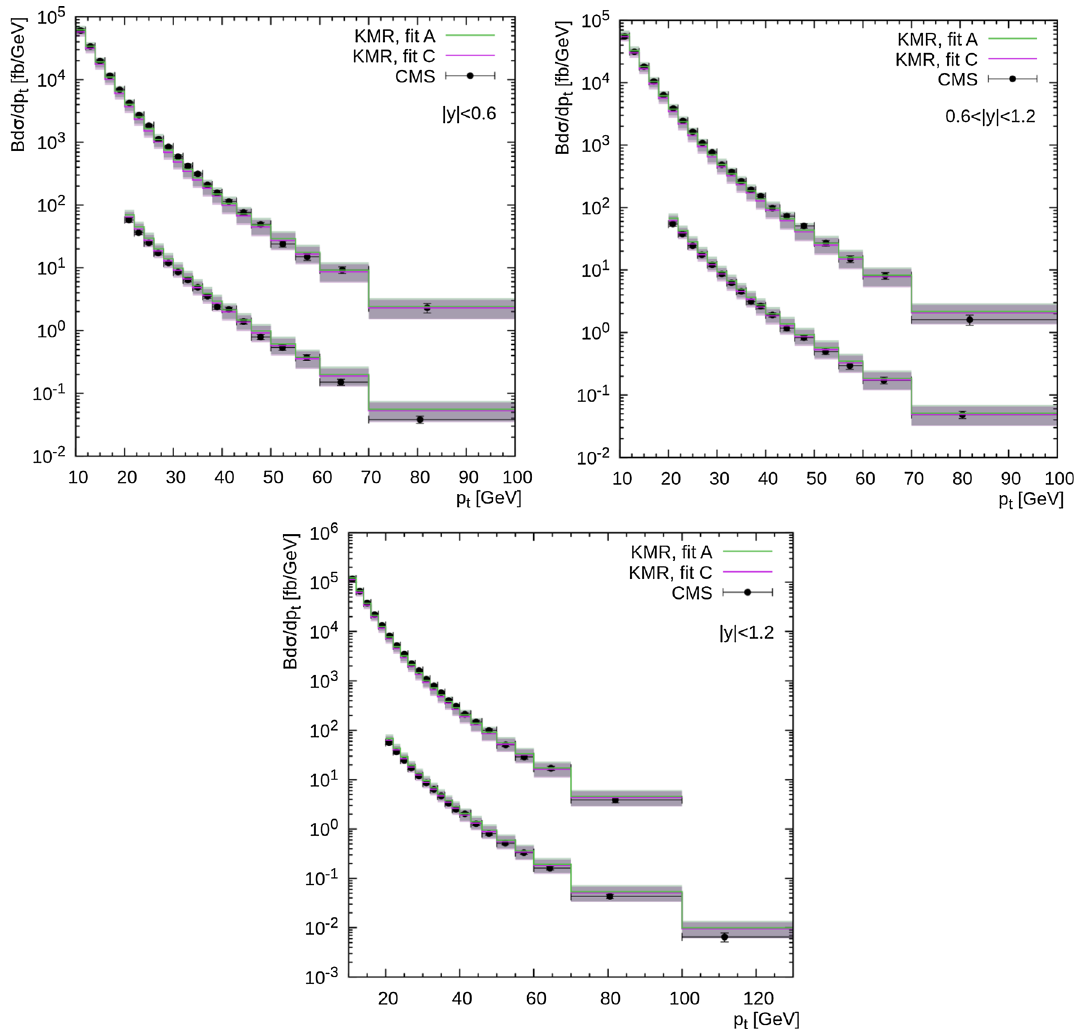
notationofallhistograms isthe sameasinFig. 6. The experimentaldata √ s = 13TeV are from CMS